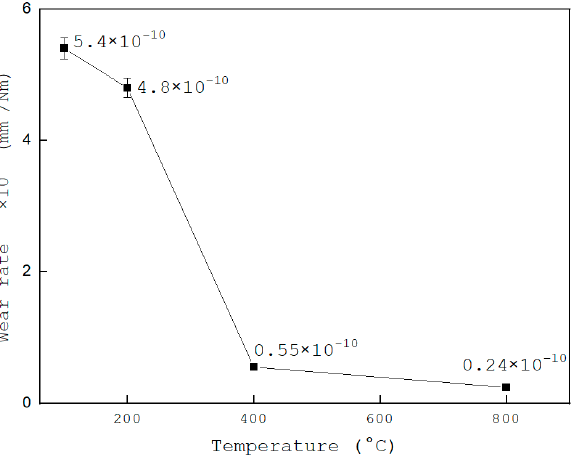
Figure 11. COF values for HfCN coatings during the 500 m as a function of temperature.